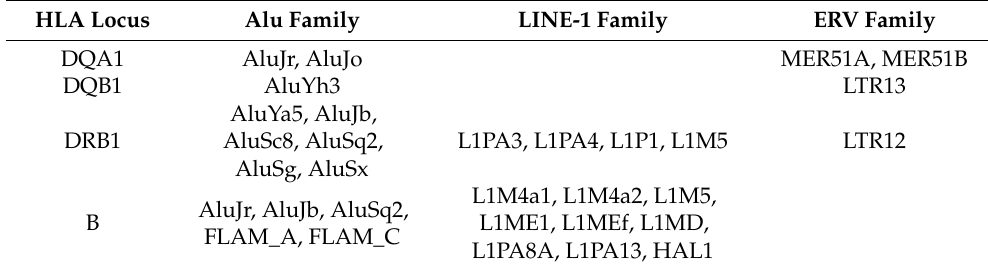
Table 1. Important human leukocyte antigen ( HLA ) loci regarding T1D and retrotransposons of selected families in 6p21 genome region.